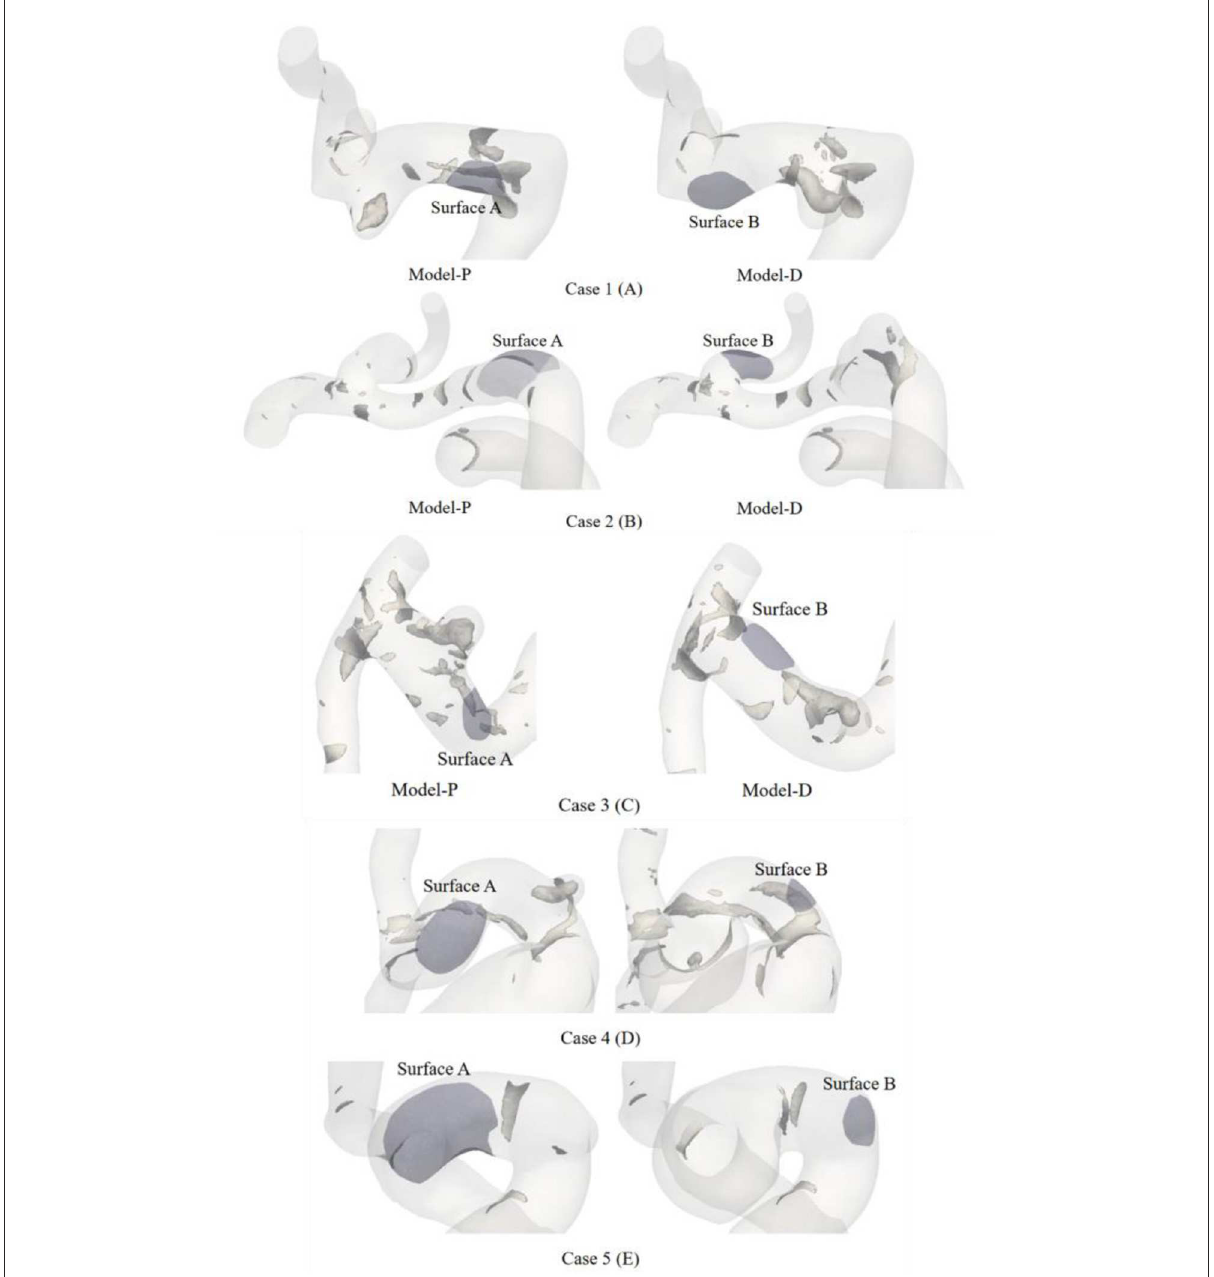
FIGURE5 The hyaline body is the vessel, the tubular gray bodies clustered on the surface of the vessels are the vortex core. Vortex core in the parental intravascular region was recognized by positive Q-criterion. The violet area in each case presents the aneurysm ROI